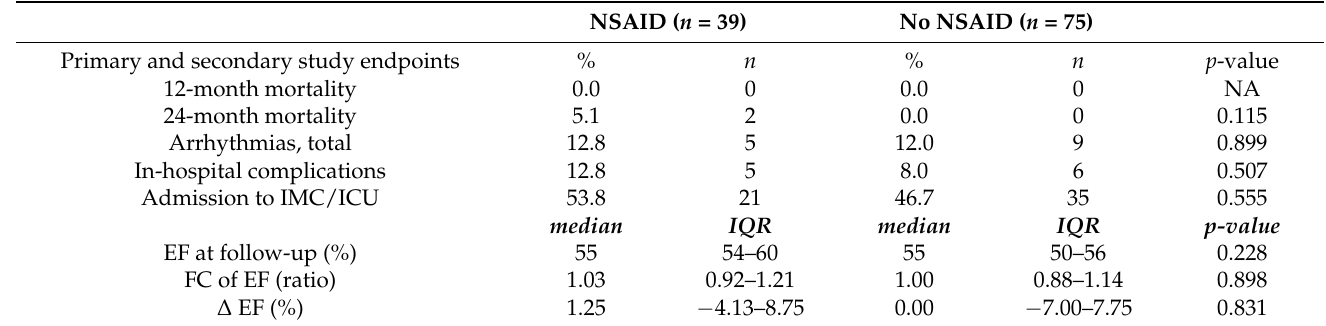
enzyme inhibitors, ARB = angiotensin receptor blockers, MRCA = mineralocorticoid receptor an- Table 3. Data on the primary and secondary study endpoints in patients of both groups prior to tagonists, NA = not applicable. propensity score matching.